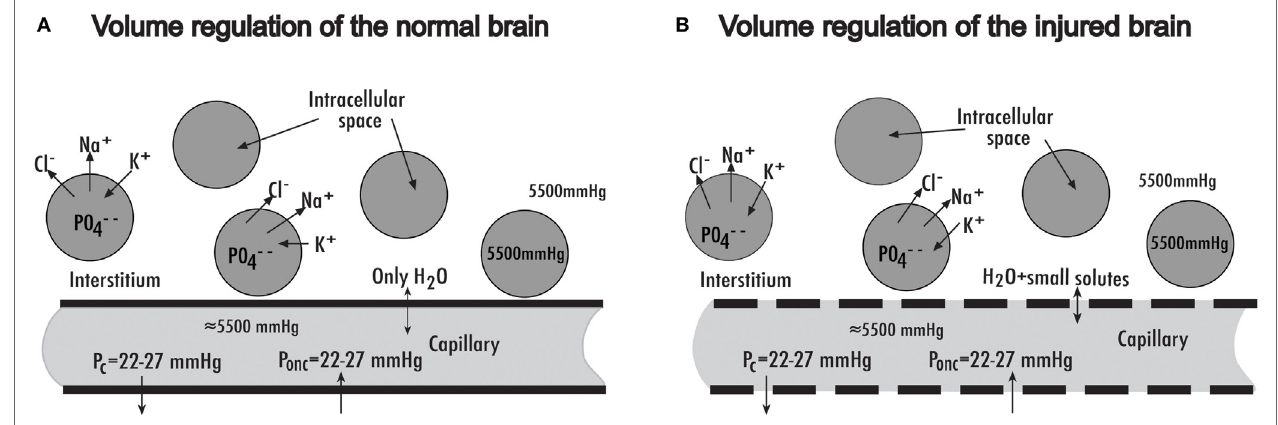
FiGURe 1 | (A) Schematic illustration of a cerebral capillary in the normal brain with intact blood–brain barrier (BBB), also showing the Starling forces (transcapillary hydrostatic and oncotic pressures) responsible for transcapillary fluid exchange. Only water can pass through the intact BBB passively. (B) Cerebral capillary and the Starling forces in the injured brain with disrupted BBB, in which the capillaries are passively permeable to water and small solutes. For more details of the volume regulation mechanisms in the normal and injured brain, see text. Reproduced from Ref. (3), with